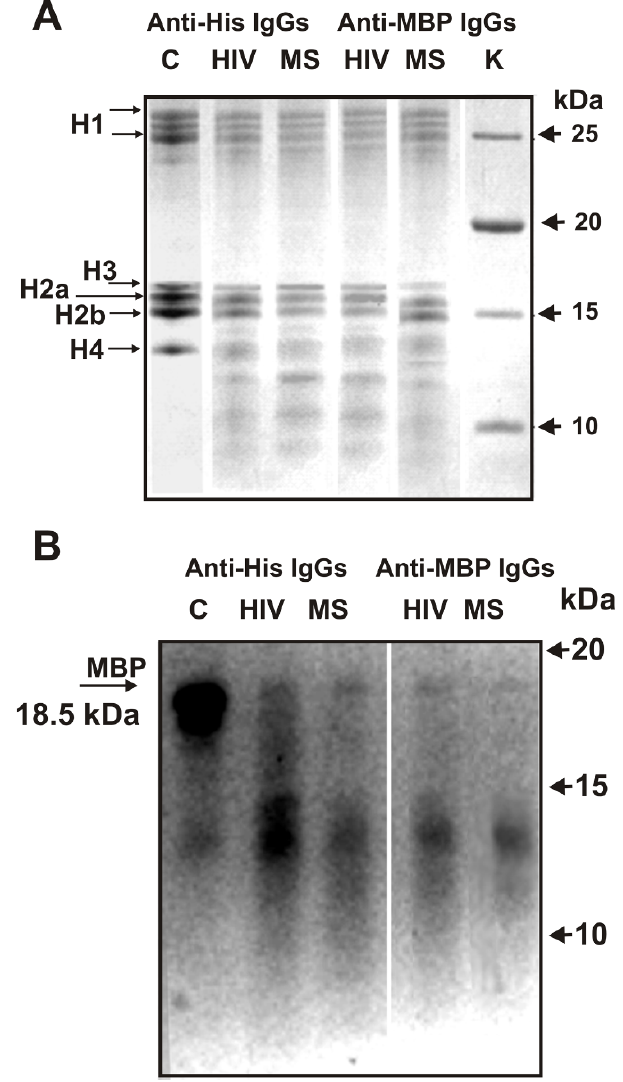
Figure 2. SDS-PAGE analysis of hydrolysis of five histones ( A ) and MBP ( B ) by antibodies against five histones and MBP from the blood of HIV-infected and MS patients. Lanes C corresponds to the histones ( A ) and MBP ( B ) incubated without IgGs. Lane K–control markers of proteins molecular mass ( A ). MBP and a mixture of five histones with and without IgGs (0.03 mg/mL) were incubated for 12 h. Designations of IgGs and diseases are shown in the figure.